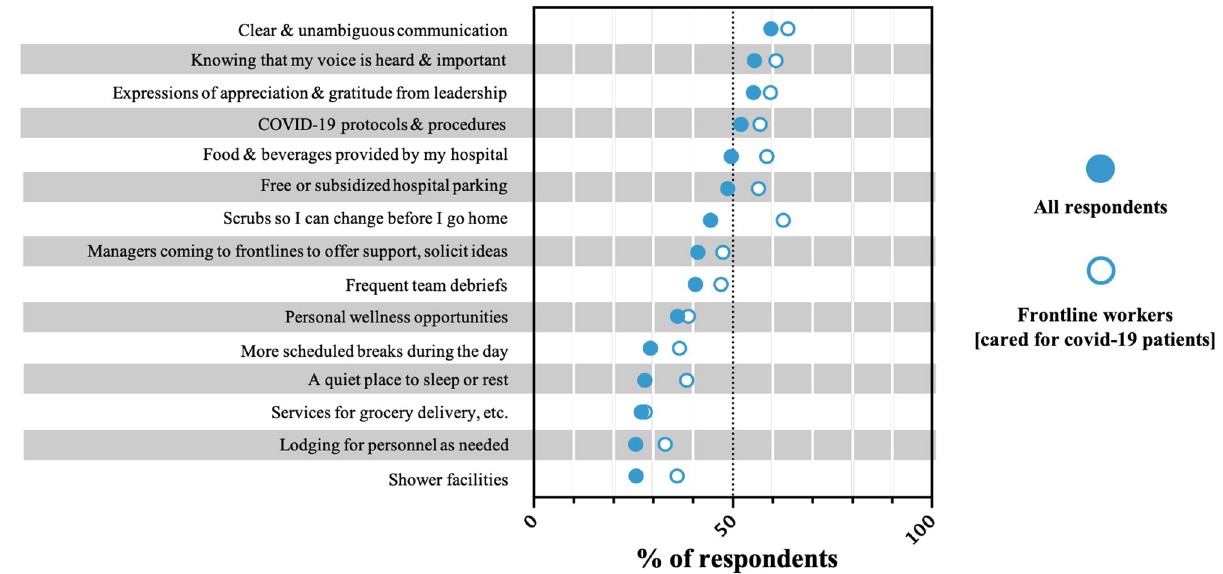
Fig 5. Preferred workplace strategies to help staff cope with the stresses of the COVID-19 pandemic. Data is presented separately for Frontline workers (unfilled circles) and All respondents (filled circles), which is inclusive of frontline and non-frontline workers to inform strategic implementation of supportive strategies either broadly (for all hospital workers) or targeted towards frontline workers